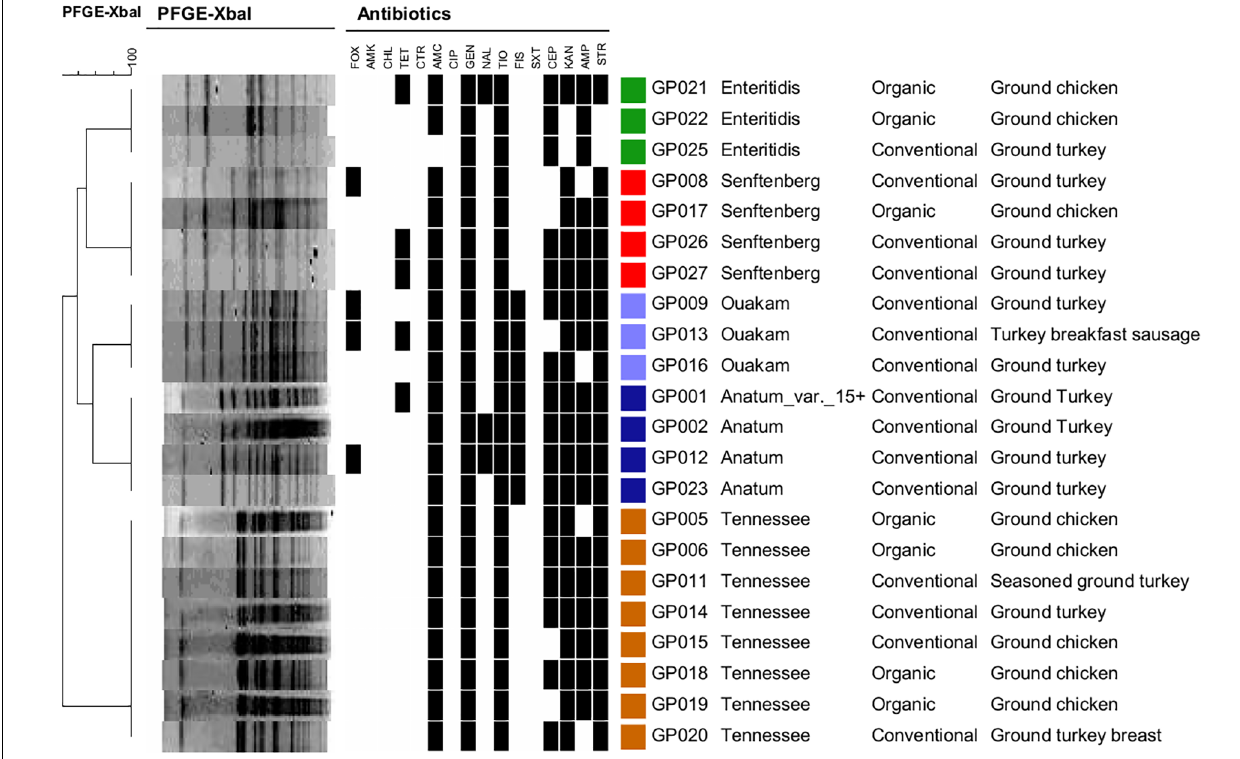
FIGURE 2 | Dendogram and pulsed field gel electrophoresis (PFGE) profiling of 22 Salmonella isolates using Xba I. Antibiotic resistance, serotypes, and the ground poultry sources are shown for the 22 PFGE-typable Salmonella strains. Similarity analysis was performed using the Dice coefficient, and clustering was performed using UPGMA based on PFGE profiles. Black squares indicate resistance. FOX, cefoxitin; AMK, amikacin; CHL, chloramphenicol: TET, tetracycline; CTR, ceftiaxone; AMC, amoxicillin-clavulanic acid; CIP, ciprofloxac; GEN, gentamicin; NAL, nalidixic acid; TIO, ceftiofur; FIS, sulfisoxazole; SXT, trimethoprim/sulfamethoxazole; CEP, cephalothin, KAN, kanamycin; AMP, ampicillin; STR,